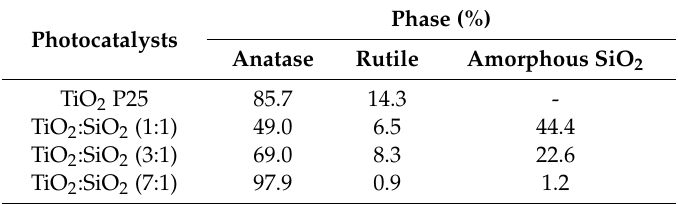
Table 1. Percentage of anatase, rutile and amorphous SiO 2 phase in photocatalysts. Photocatalysts Phase (%) Anatase Rutile Amorphous SiO 2